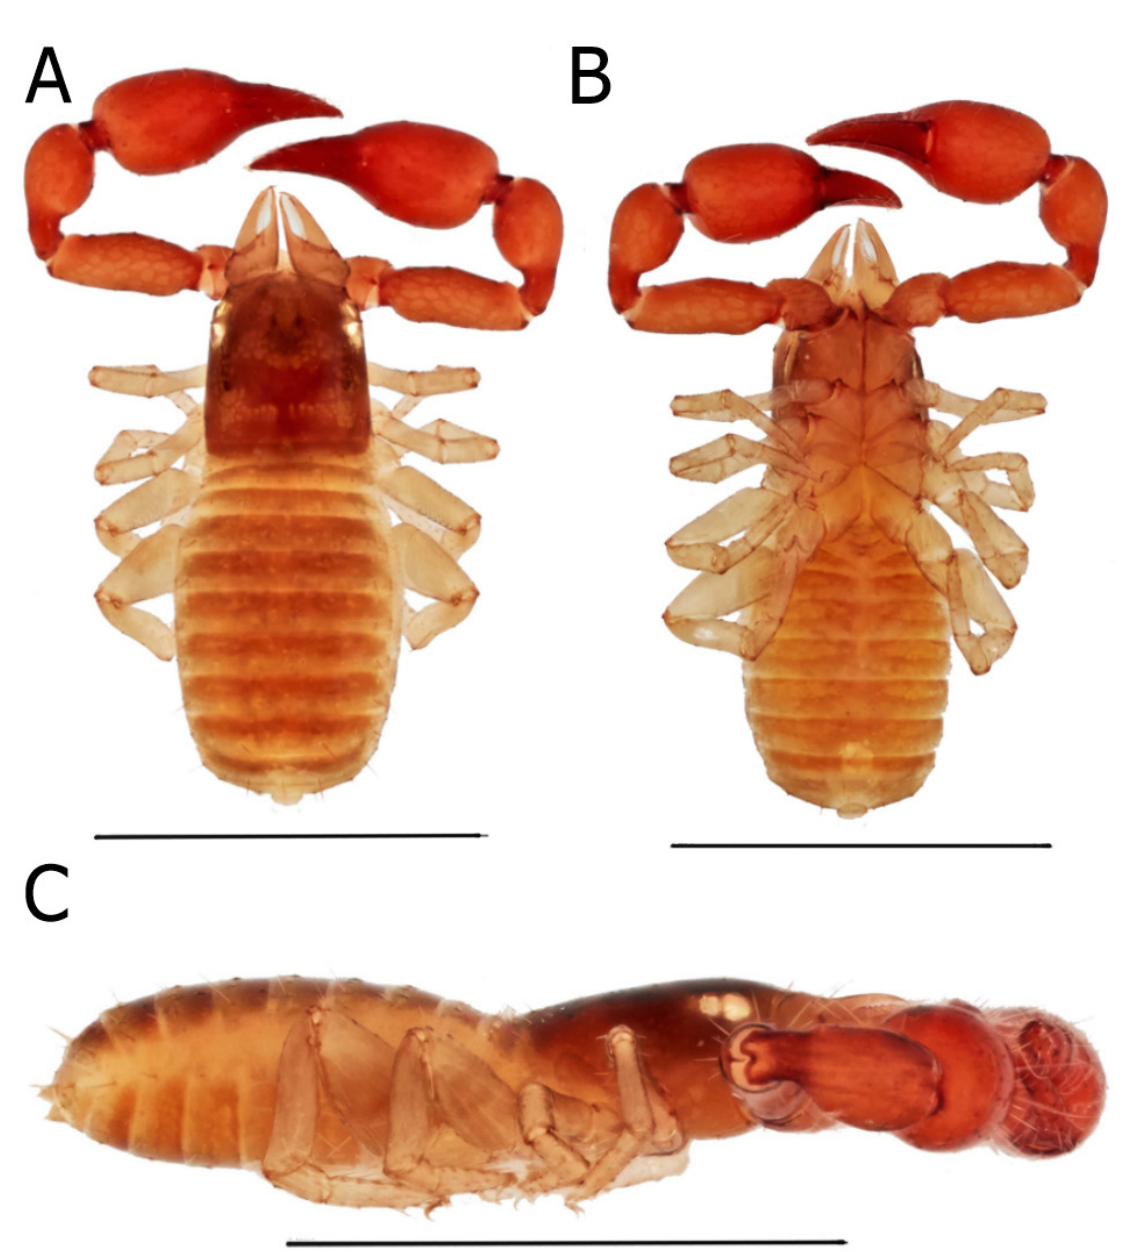
Fig. 15. Ideobisium susanae sp. nov., allotype, ♂ (QCAZ). A . Habitus in dorsal view. B . Habitus in ventral view. C . Habitus in lateral view. Scale bars = 1